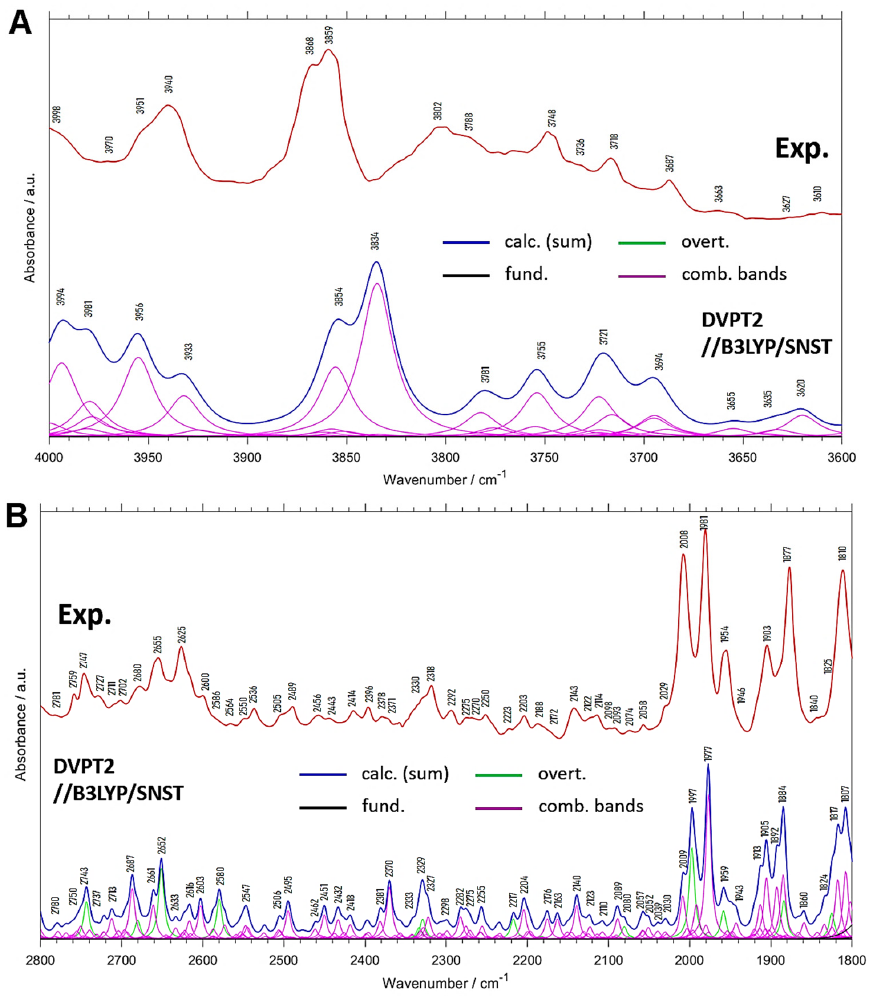
Figure 3. Spectrum of crystalline menadione in the 4000–3600 cm − 1 ( A ) and 2800–1800 cm − 1 ( B ) range together with the anharmonic (DVPT2//B3LYP/SNST) spectrum. Table 3. Experimental and calculated band positions [cm − 1 ] together with calculated relative intensities [%] (normalized to the intensity of 3063 cm − 1 band; see Table 2) and assignments of the fundamental bands in the 4000–3600 cm − 1 range for crystalline